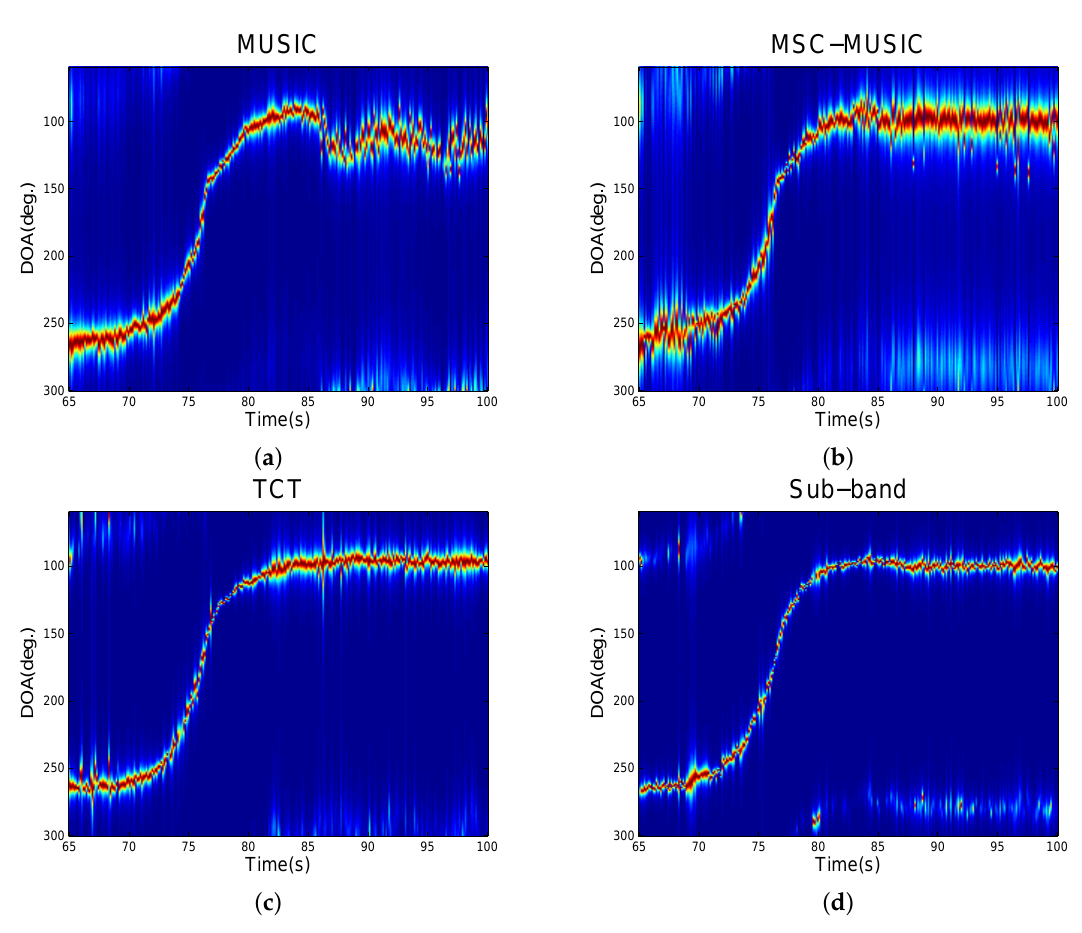
Figure 10. Vehicle tracking under interferences. ( a ) is from the multiple signal classification (MUSIC); ( b ) is from the magnitude-squared coherence (MSC)-MUSIC; ( c ) is from the two-sided correlation transformation (TCT); ( d ) is from the proposed sub-band